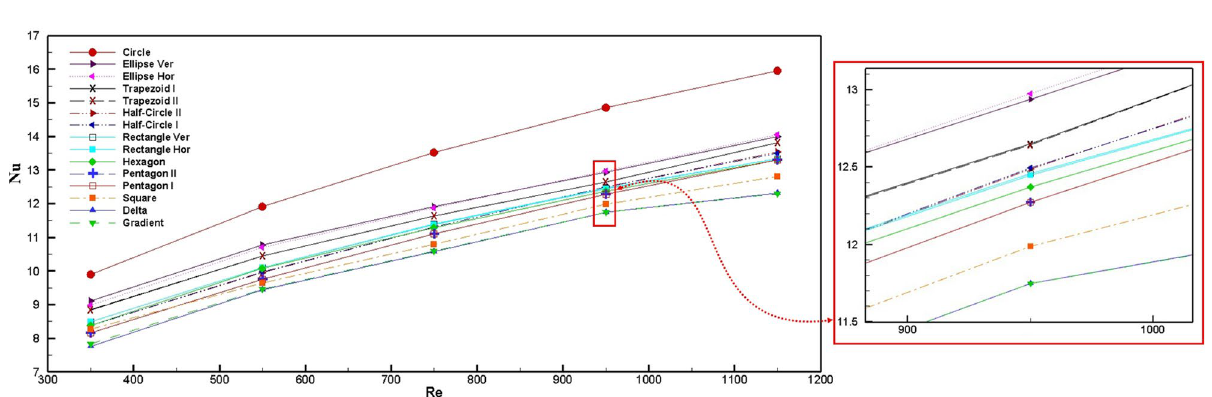
Figure 4. Average Nusselt number for different cross-sections of microchannel at different Reynolds